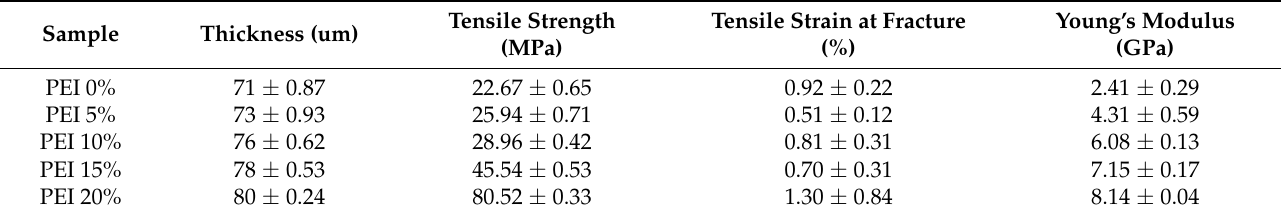
Table 1. The results of tensile tests of the composite